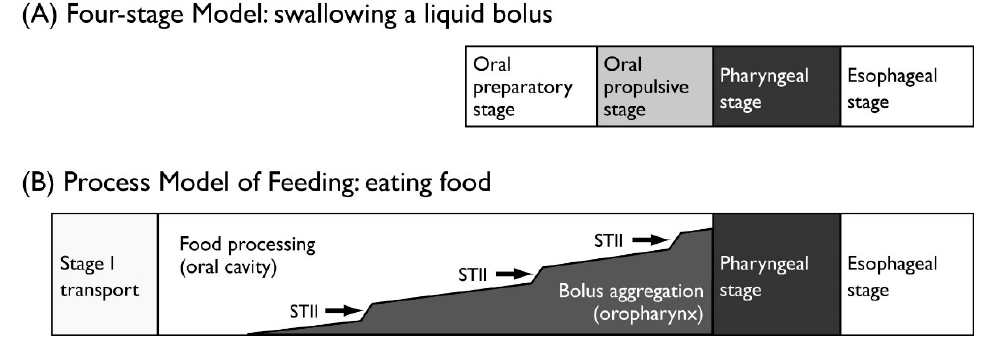
Figure 1. Models for consuming ( A ) liquids and ( B ) solids. ( A ) Four-stage Model. When drinking liquids, there is minimal temporal overlap between stages. ( B ) Process Model of Feeding. When eating solid food, the timing of food processing and stage II transport (STII; with aggregation in the oropharynx) can overlap substantially.